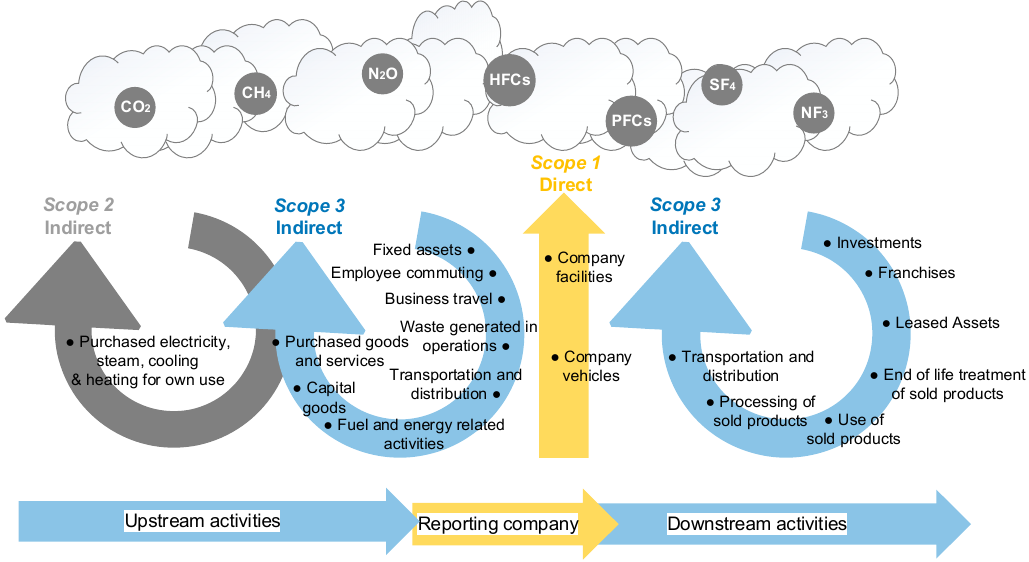
Figure 6. Overview of the GHG protocol scopes and emissions across the value chain [50].